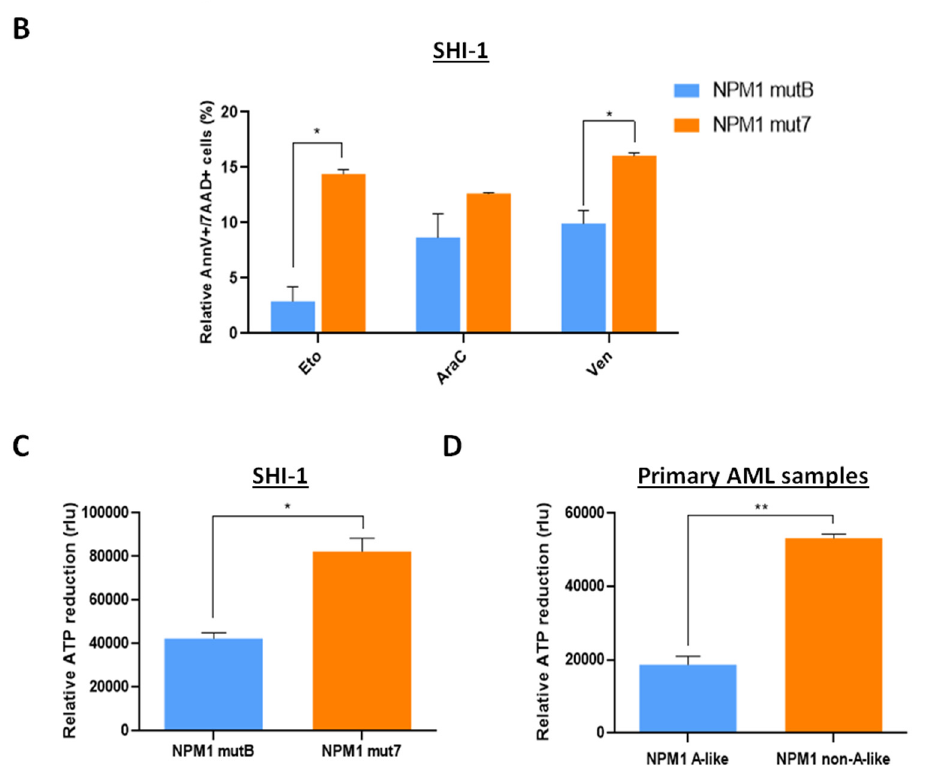
Figure 4. Treatment sensitivity in different NPM1-mutated cells. ( A ) Percentage of Annexin-V/7AAD positive cells, relative to DMSO, 48 h after Eto (1 µ M), AraC (2.5 µ M), Ven (5 nM), in HL-60 cells transfected with pEGFP-NPM1mutA, mutB, mutD (A-like) or pEGFP-NPM1mut5, mut7 (non-A-like) plasmids, gating on EGFP positive cells. In the lower panel is reported the mean of Annexin-V/7AAD positive cells after treatment, considering A-like and non-A-like mutations together. * p -value < 0.05, ** p -value < 0.01, *** p -value < 0.001, **** p -value < 0.0001. ( B ) Percentage of Annexin-V/7AAD positive cells in SHI-1 transfected with pEGFP-NPM1mutB (A-like) or pEGFP-NPM1mut7 (non-A-like) plasmids, gating on EGFP positive cells and relative to DMSO, after 48-h of treatment with Eto (1 µ M), AraC (2.5 µ M), or Ven (1 µ M). * p -value < 0.05. ( C ) Reduction of cell viability measured by ATP assay after 24 h of treatment with Eto (1 µ M), relative to DMSO, in SHI-1 cells transfected with pEGFP-NPM1mutB (A-like) or pEGFP-NPM1mut7 (non-A-like) vectors. * p -value < 0.05. ( D ) Reduction of cell viability measured by ATP assay after 24-h treatment with AraC (2.5 µ M), relative to DMSO, in primary AML samples harboring A-like or non-A-like NPM1 mutations. ** p -value < 0.01. rlu: relative luminescence